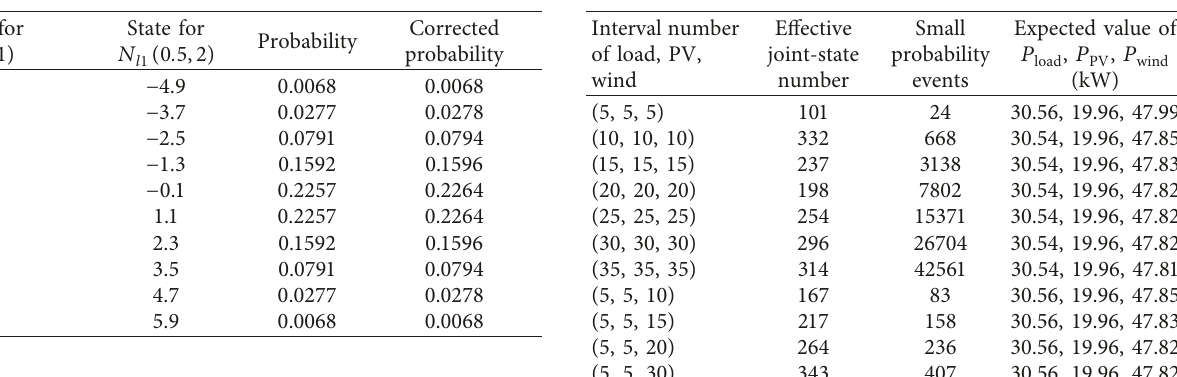
Table 1: State variables and probability of N